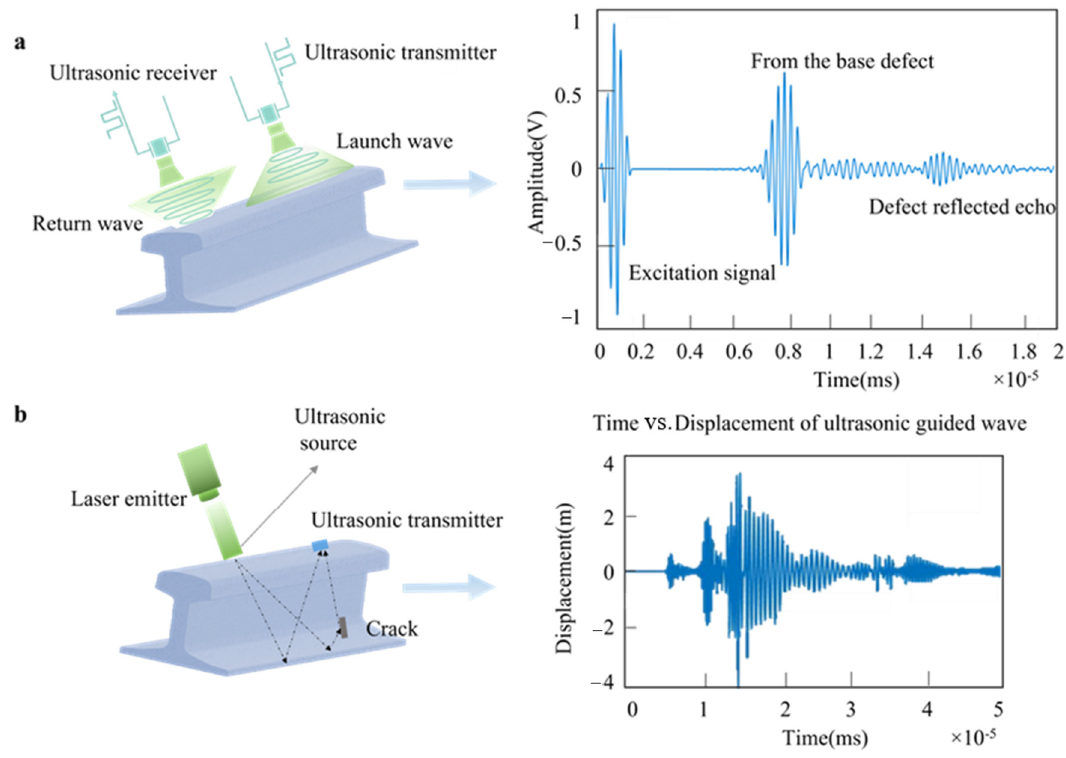
Figure 3. ( a ) Piezoelectric transducer excitation. ( b ) Laser excitation.